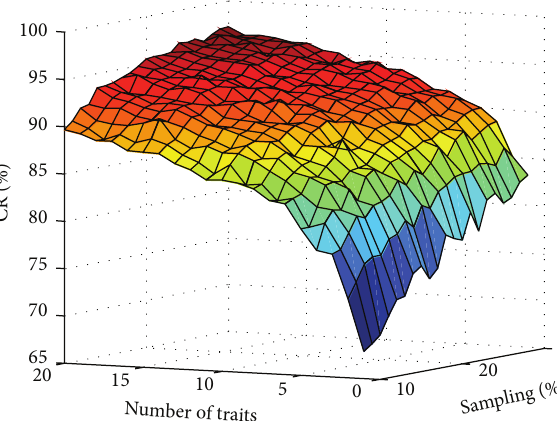
Figure 1: The 3D curved surface of CR changing by the sampling percentage and the number of